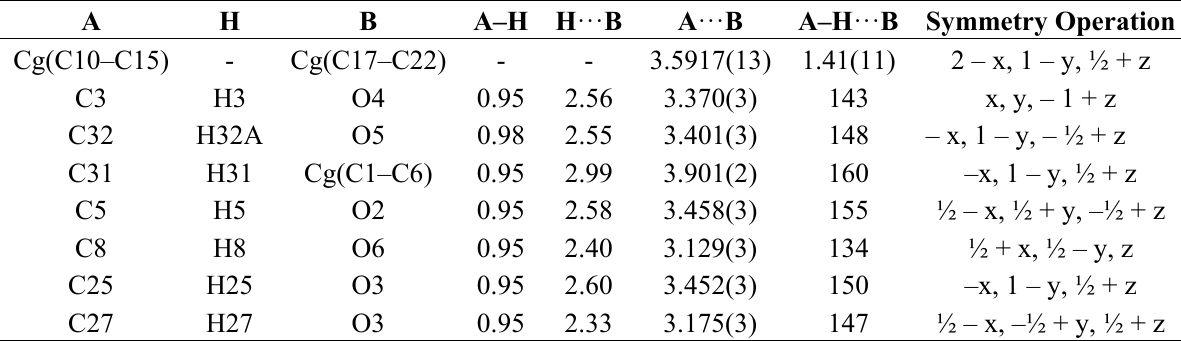
Table 1. Geometric parameters describing intermolecular interactions (A–H···B; Å) operating in the crystal structure of 1 .